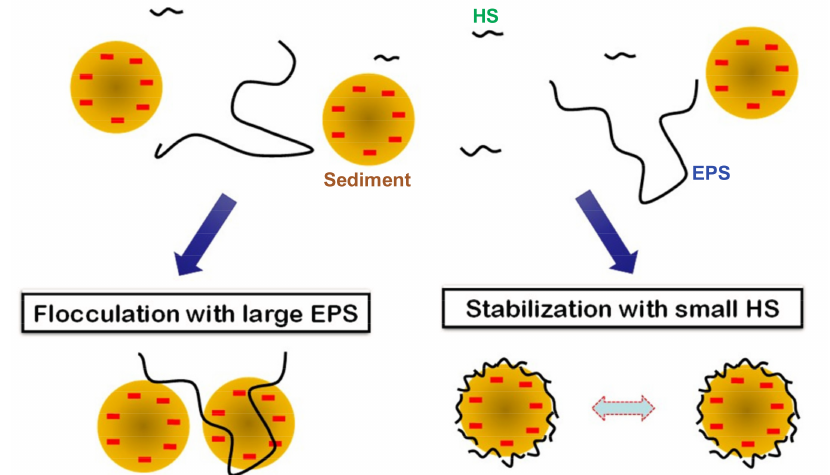
Figure 9. Schematic diagram illustrating the conceptual model of extracellular polymeric substances (EPS)-mediated flocculation and humic substance (HS)-mediated stabilization in the mixture of EPS and